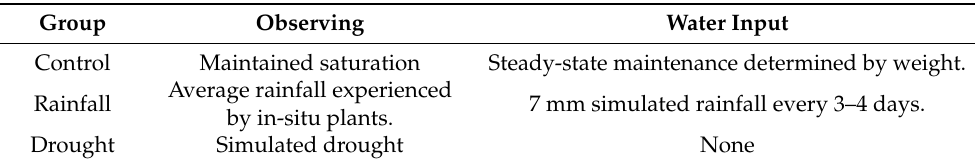
Table 3. Water Inputs for Each Sample